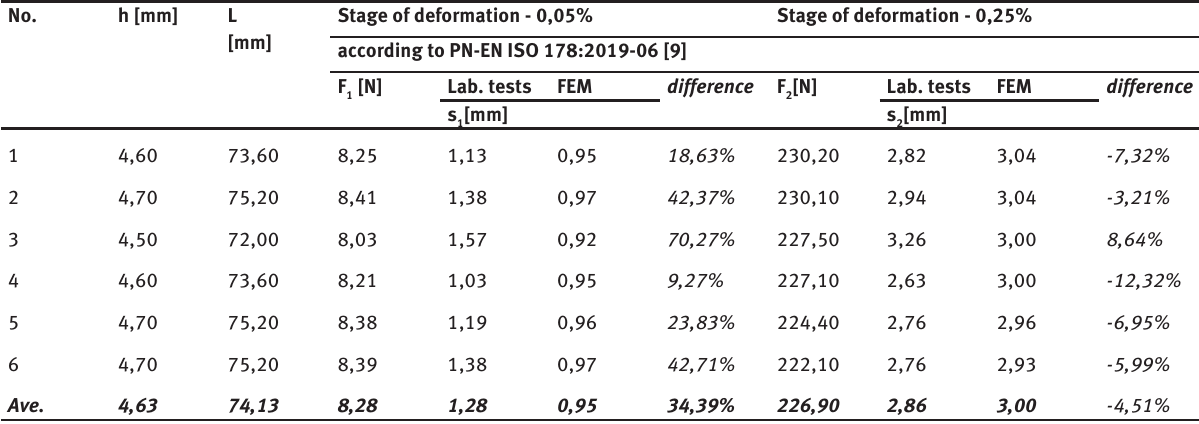
Table 4: Comparison of results of numerical analyses and laboratory tests for a model of a liner with a diameter of 200mm and 4,50mm wall thickness.